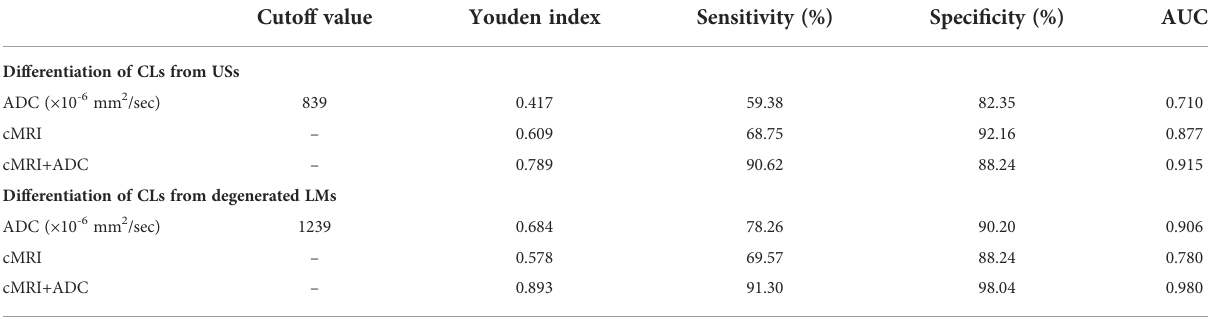
TABLE 3 Measurements of the cut-off value, sensitivity, speci fi city, and AUC of ADC, conventional MRI parameters, and combination of ADC and cMRI parameters for differentiating CLs from USs and degenerated LMs. Cutoff value Youden